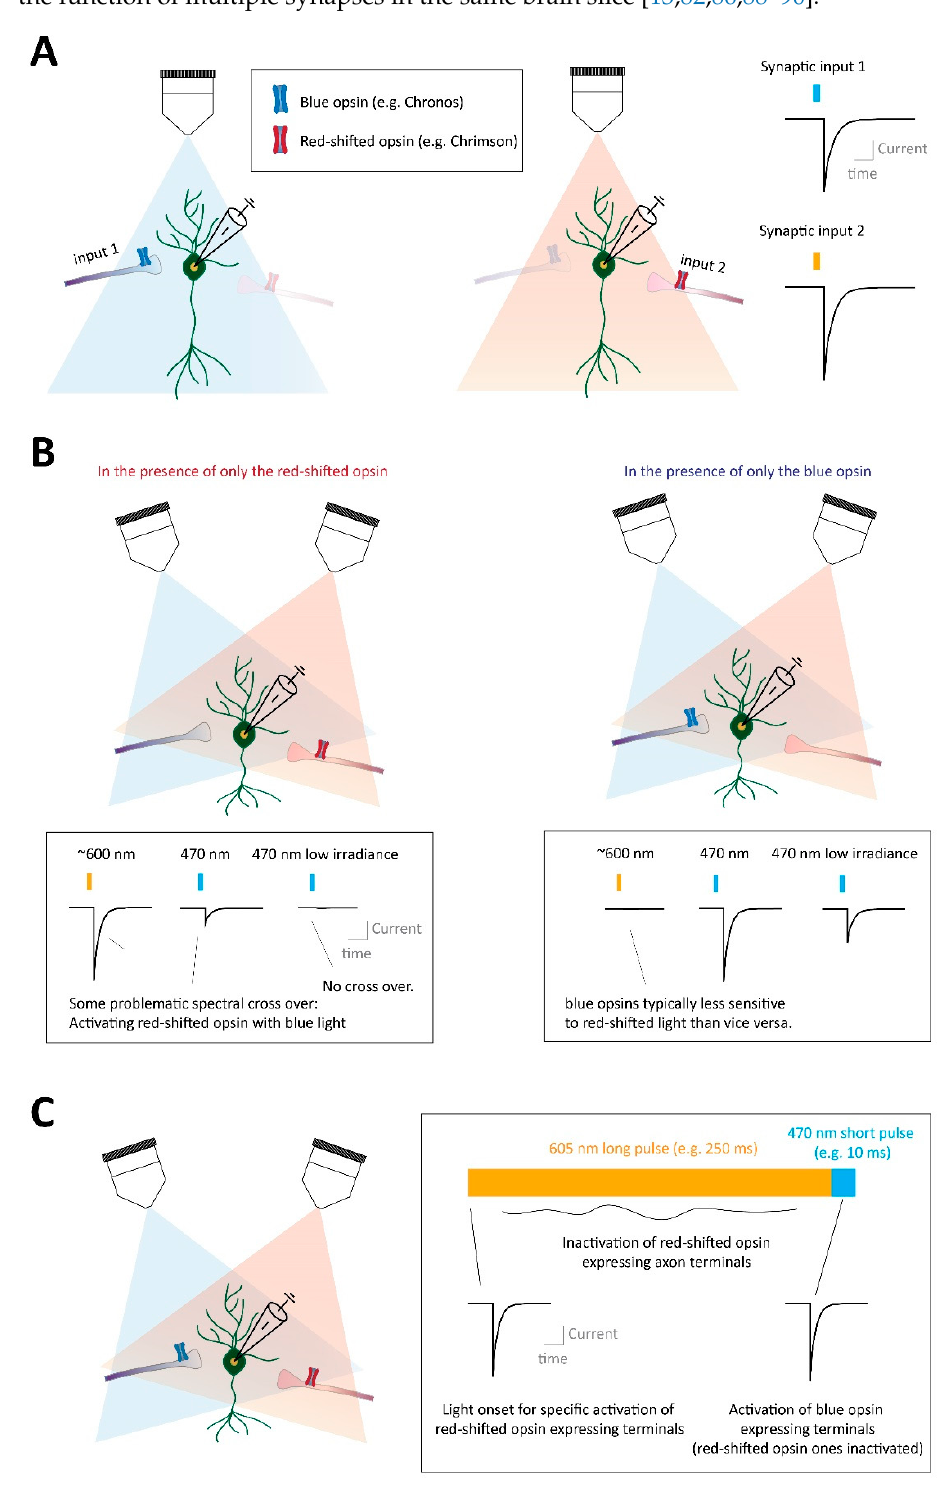
Figure 3. Dual color optogenetics to assess properties of multiple synapses in a neural circuit. ( A ) When combining expression of a blue light sensitive opsin (e.g., ChR2 or Chronos) with a more red-shifted opsin (e.g., Chrimson) in distinct presynaptic sources, it becomes possible to stimulate sep- arate synaptic inputs in a slice, by stimulating the tissue with blue light wavelengths vs. red-shifted ones. ( B ) Control experiments are required to assess the extent of spectral cross over. Left: A situa- tion where only the red-shifted opsin (Chrimson) has been expressed, and the tissue is stimulated with either blue or orange wavelengths. Orange wavelengths indeed activate the axon terminals